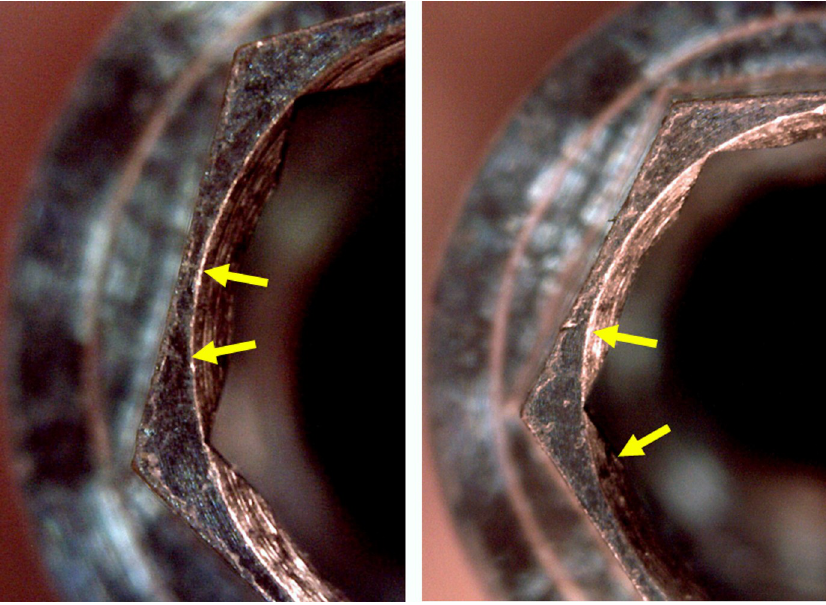
Fig 7. Representative image showing what happened in the samples of groups EH and IH after the application of 100 and 120 Ncm of torque, respectively. Yellow arrows show the marks in the local where occurred the fissures in the implant